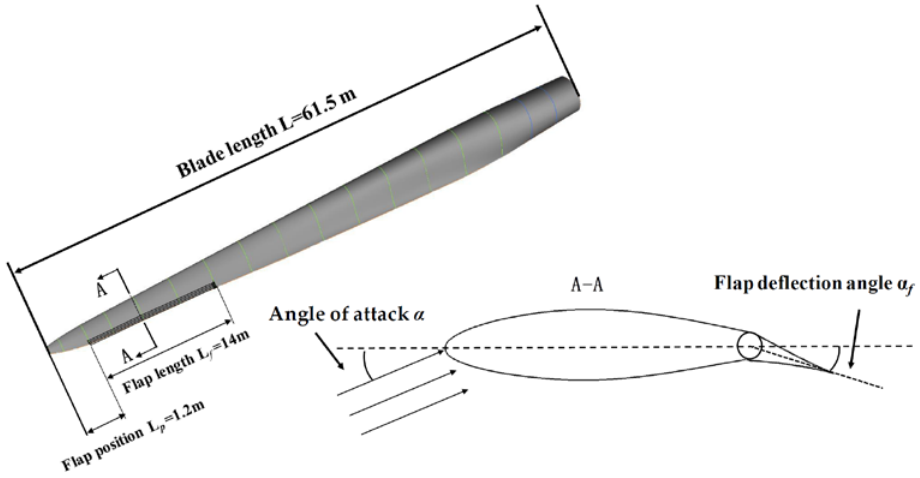
Figure 3. Blade structure with trailing-edge flap.